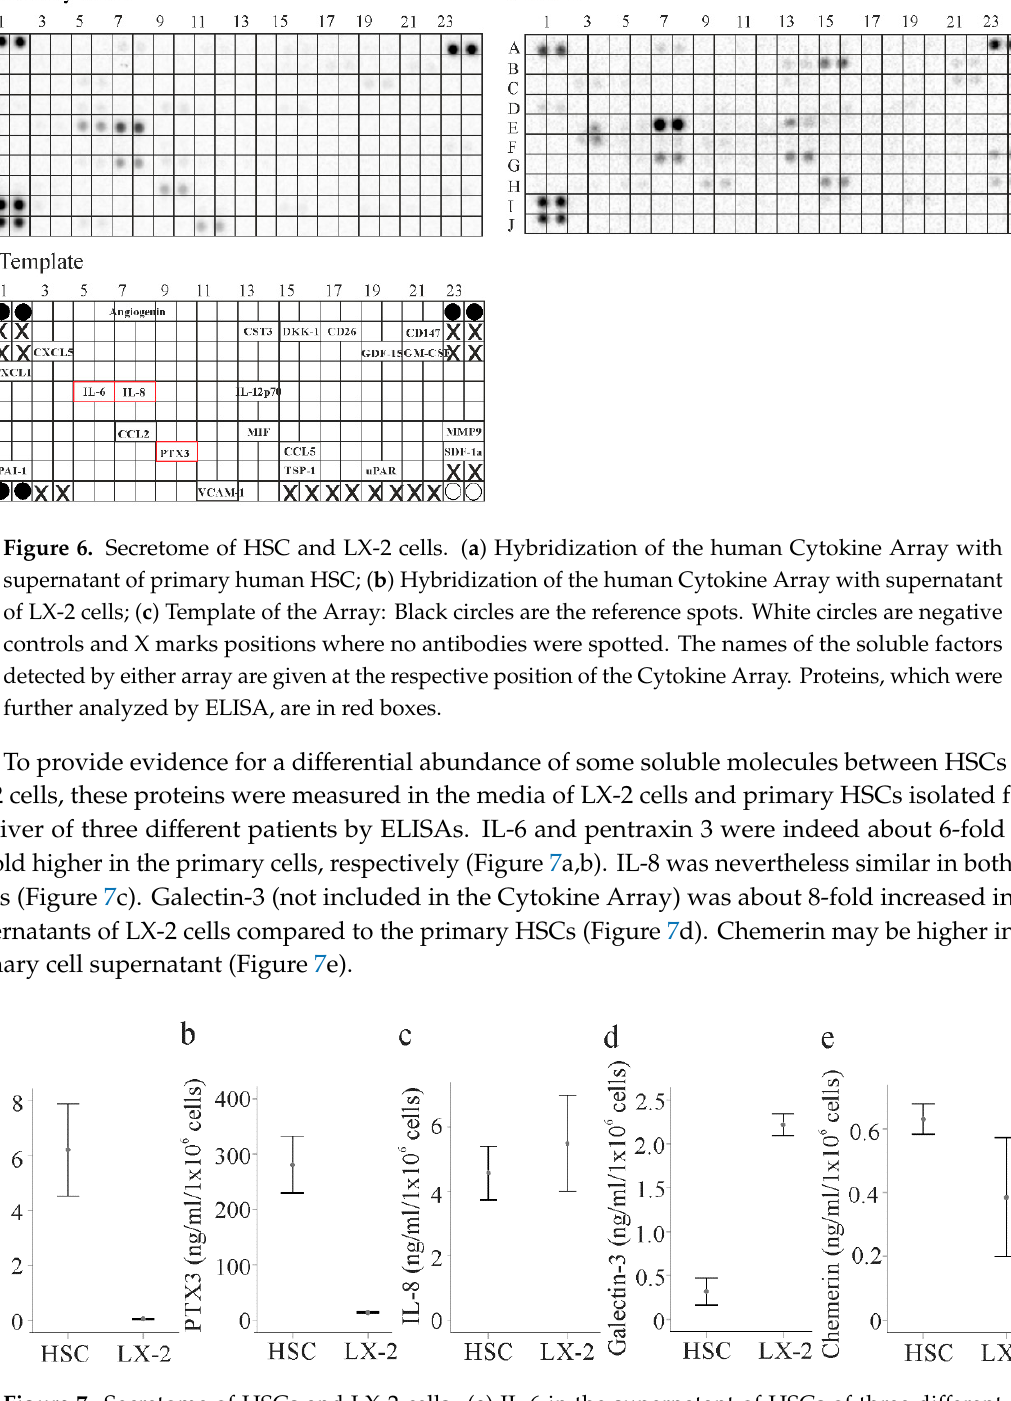
Figure 7. Secretome of HSCs and LX-2 cells. ( a ) IL-6 in the supernatant of HSCs of three different donors and LX-2 cells; ( b ) Pentraxin 3 (PTX3); ( c ) IL-8; ( d ) galectin-3; and ( e ) chemerin in the cell culture media of these cells.